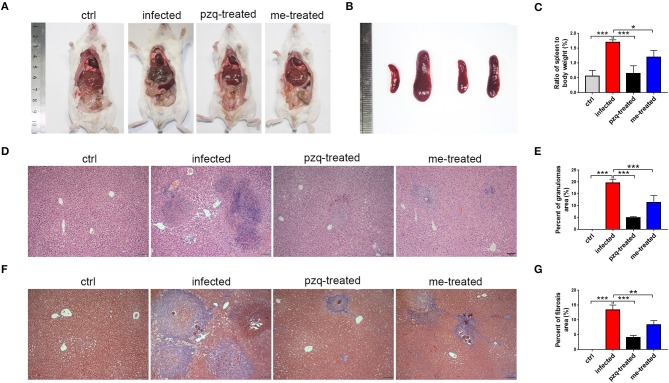
Comparison of the granulomatous inflammation in the liver and pathological changes in the spleen. (A) Anatomy images of liver were taken by Nikon DSLR Camera. (B) Pathological changes of spleen in different groups (From left to right: ctrl, infected, treated with praziquantel, and treated with myricetin. (C) The ratio of spleen to body weight of mice infected with S. japonicum cercariae at 7 weeks. (D) Representative H&E staining images of hepatic granulomas at 7 weeks post infection with 30 S. japonicum cercariae (Scale bars: 100 μm). (E) Percent of granulomas in liver were analyzed with Image pro plus 6.0 software. (F) Fibrosis changes of liver at 7 weeks post infection with S. japonicum were observed by Masson staining (Scale bars: 100 μm). (G) The percent of fibrosis area was measured by Image pro plus 6.0. The data are expressed as the mean ± SD (n = 3). **P < 0.01, ***P < 0.001, compared with the infected group. ctrl, the control group; infected: S. japonicum infected group; pzq-treated, the praziquantel-treated group; me-treated, the myricetin-treated group.